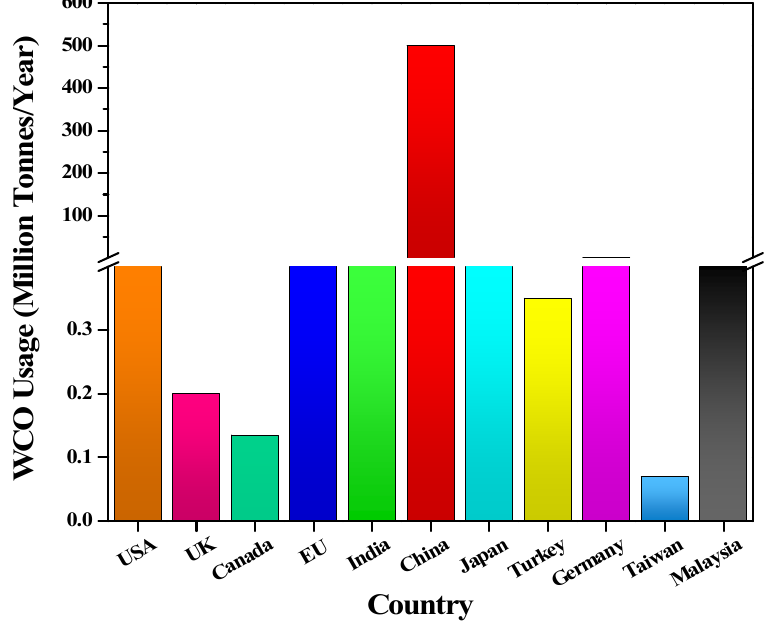
Figure 5. Amount of WCO in different regions of the world [17,39,95–100].